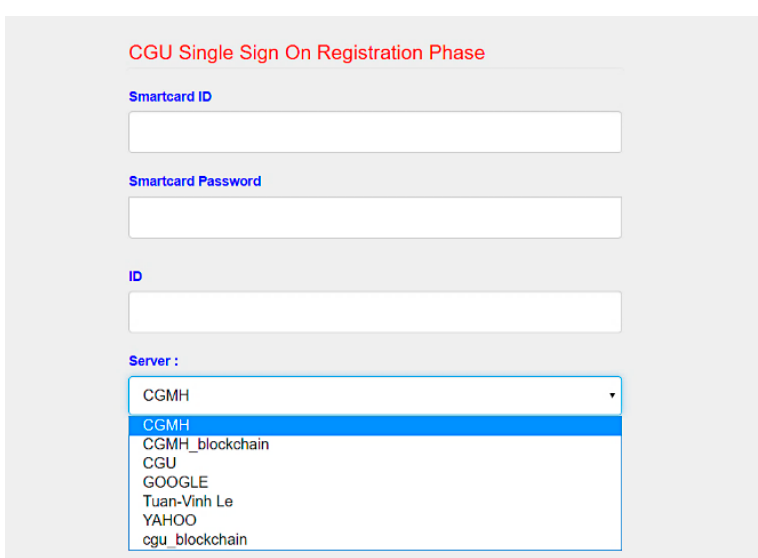
Figure 16. Interface of choosing services.